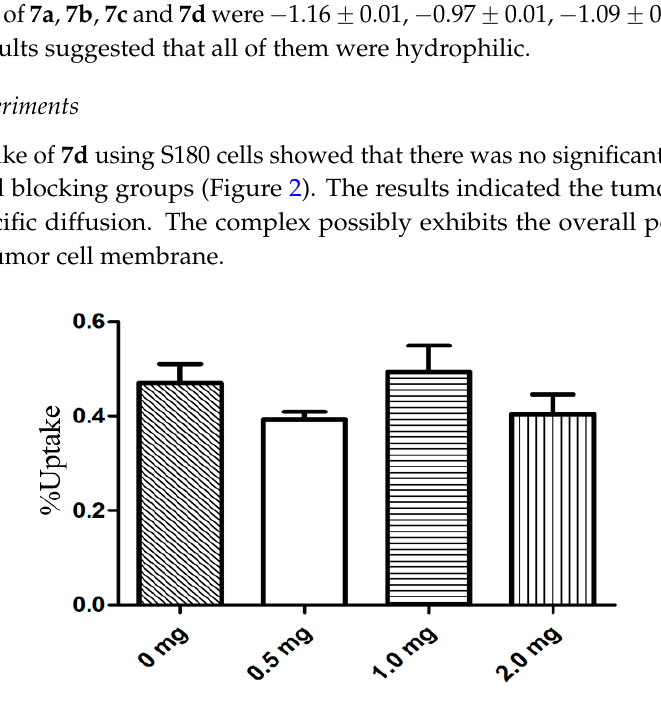
Figure 2. In vitro cell uptake of 7d when different amount thymidine was administered.